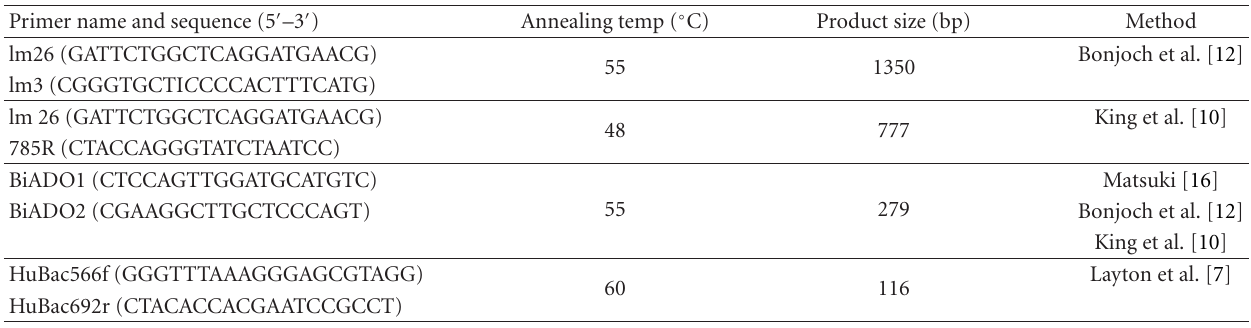
Table 1: Oligonucleotide primers (16S rDNA) used to detect fecal bacteria for each PCR assay. Primer name and sequence (5 (cid:3) –3 (cid:3) )